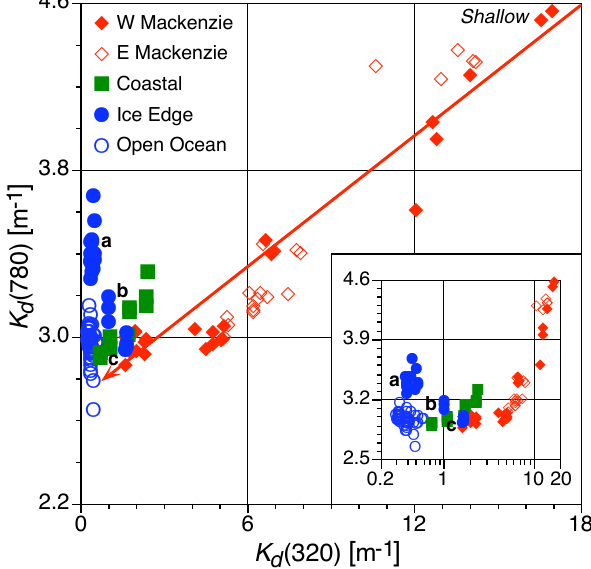
Fig. 7. A plot of K d ( 320 ) versus K d ( 780 ) for the Malina sampling, which was centered around the Mackenzie River outflow, using the same symbols as Fig. 1. The sampling included the following wa- ter masses: the open ocean (open blue circles), the western branch of the Mackenzie River (solid red diamonds), the eastern branch of the Mackenzie River (open red diamonds), coastal waters (green squares) and the ice edge (solid blue circles). The latter are further distinguished by the influence of the Mackenzie River plume: (a) no influence; (b) some influence; and (c) the most influence. The over- laid red arrow shows a progression in water properties from shal- low waters (top right) to deep waters (bottom left). The inset panel shows the same data with a logarithmic x-axis to improve the clarity of the data with low K d ( 320 ) values. sources from the Saco River (orange squares), the Kennebec River (pink squares), a coastal marsh (green squares), and near-shore sources of terrestrial inputs (dark gray diamonds and circles). The minor sources surround the periphery of the open-ocean waters of the Gulf of Maine (light gray